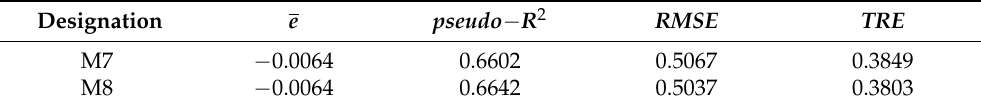
Table 9. Evaluation indicators with the model testing dataset: mean residual error ( e ), pseudo coefficient of determination ( pseudo − R 2 ), root mean square error ( RMSE ), and total relative error ( TRE ).